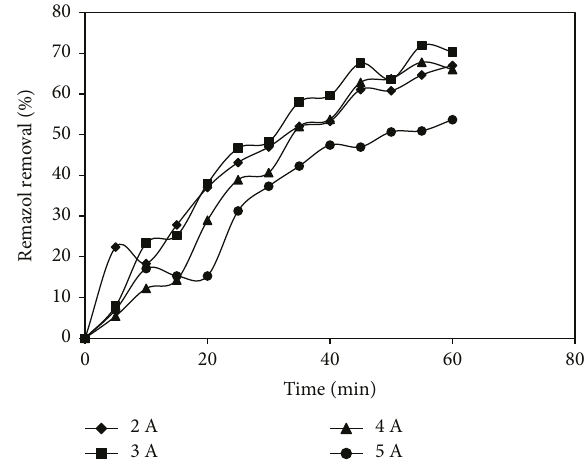
Figure 2: Removal of RYD at di ff erent current intensities: 2A, 3 A, 4 A, and 5 A.